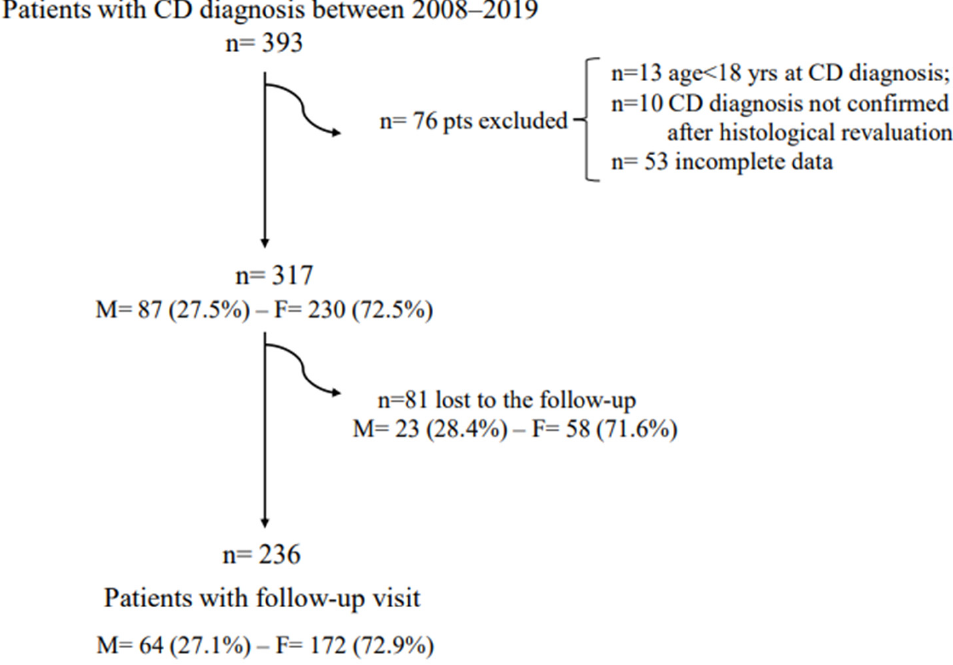
Figure 1. Flowchart of the included patients.